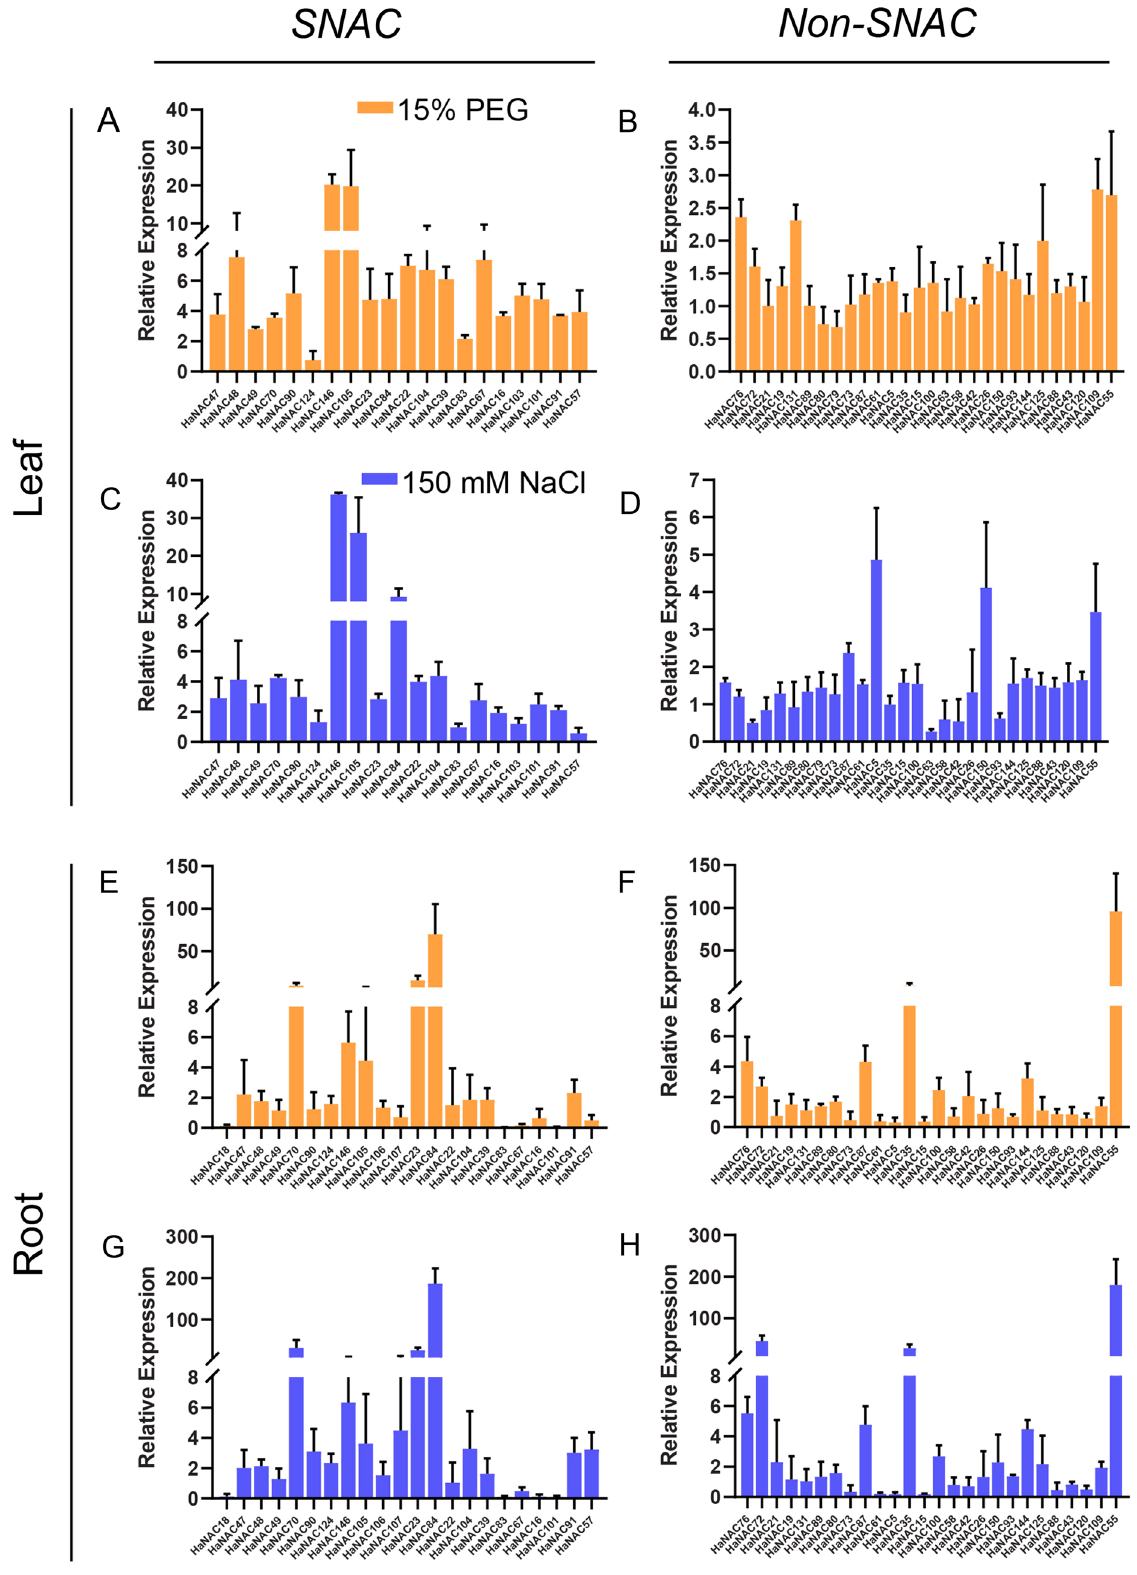
Figure 8. Relative expression of some HaNAC s under 15% PEG or 150 mM NaCl stress for 24 h, including those in the SNAC group and those in the same branch as the reported NACs in the Non-SNAC group. ( A – D ) showed the conditions of gene expression in leaves; ( E – G ) represented those in roots; ( A , C , E , G ) showed the results of SNAC gene expression; ( B , D , F , H ) indicated those of Non - SNAC genes; ( A , B , E , F ) showed the results of gene expression to PEG stress and ( C , D , G , H ) as the results to NaCl